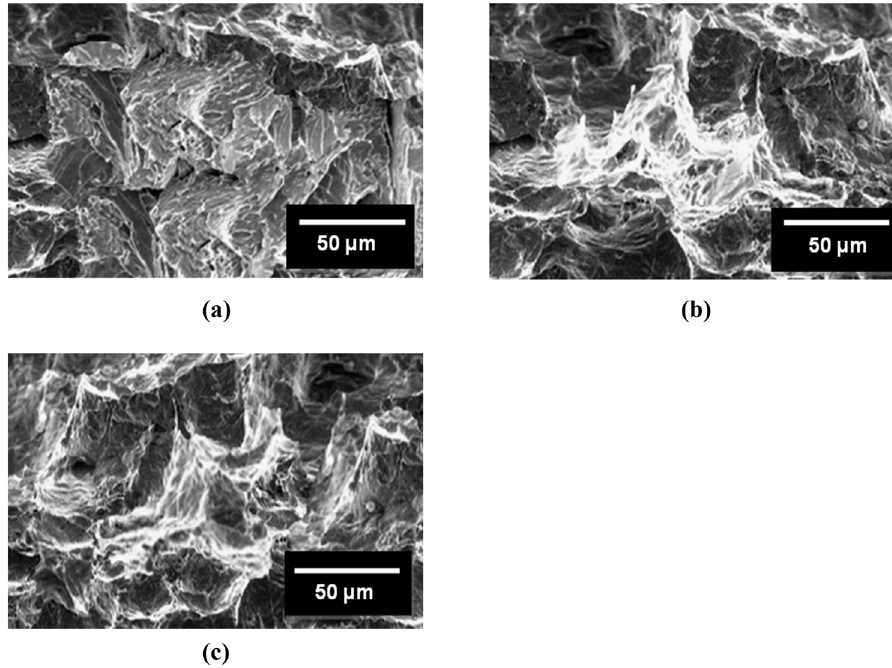
Figure 4: SEM images of fractured ( a ) SEM fractograph of W - A, ( b ) SEM fractograph of W - 3C, and ( c ) SEM fractograph of W -